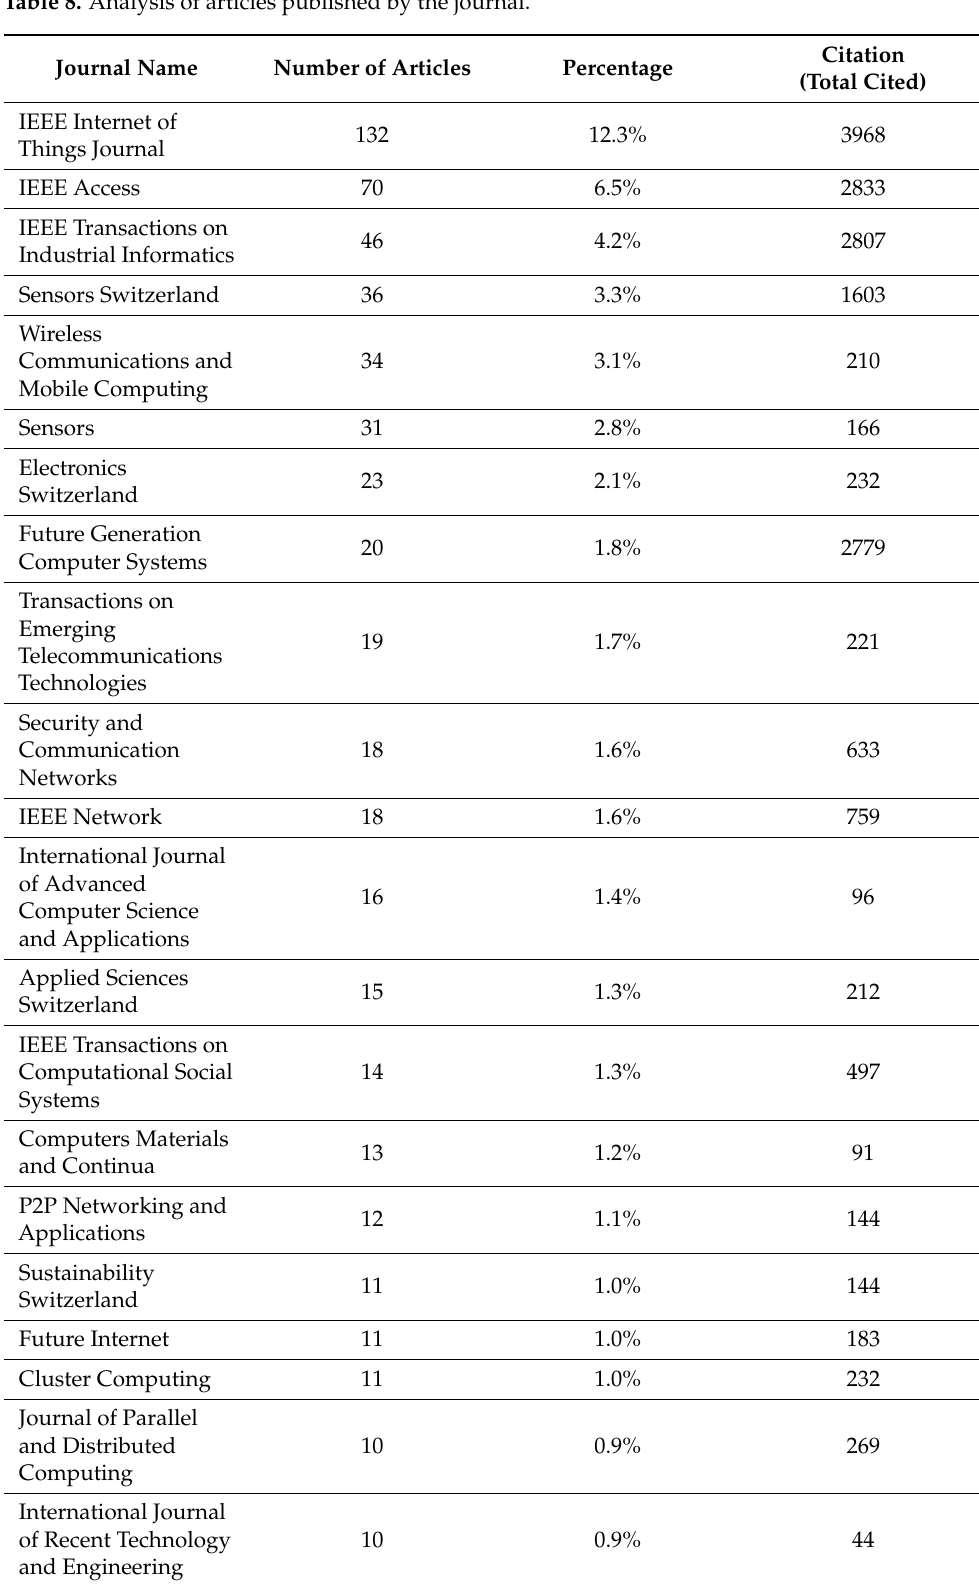
Table 8. Analysis of articles published by the